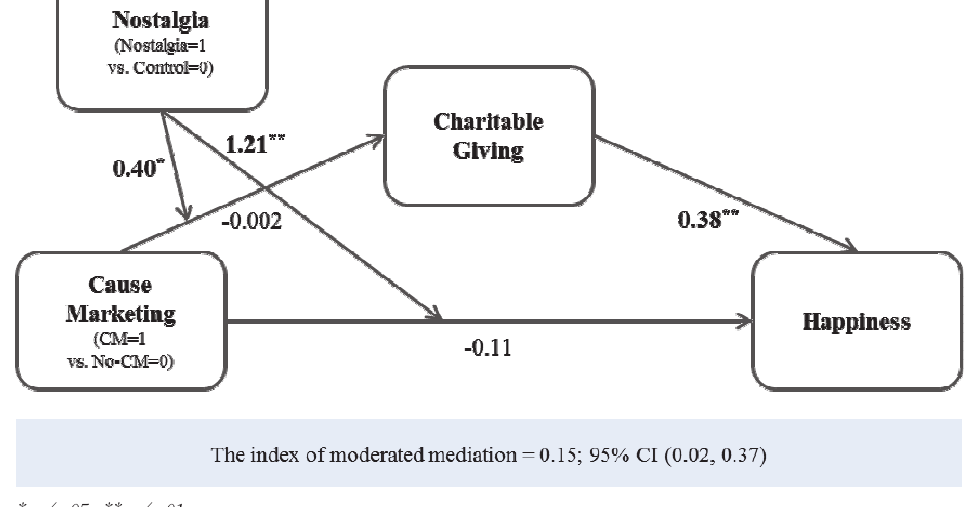
*p < .05, **p < .01 Notes: Number of bootstrap samples = 5,000. Regression coefficients are